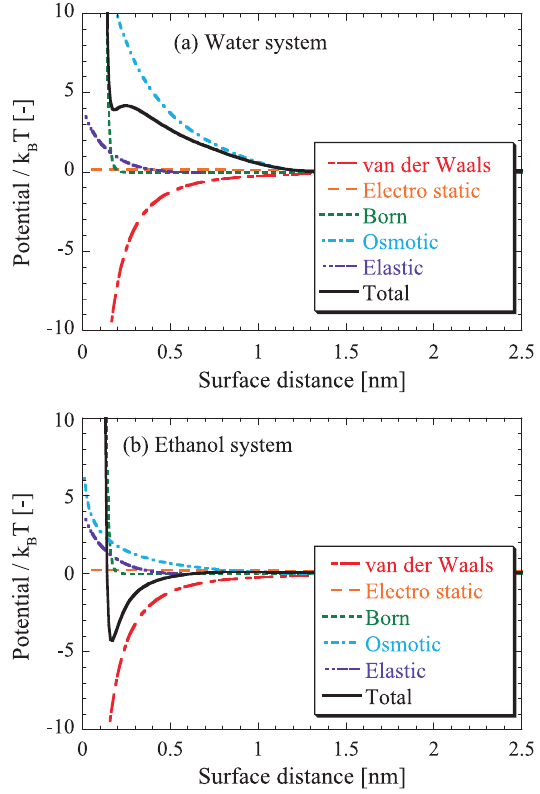
Fig. 5 Individual and total interaction potentials of 1-thioglycerol- capped ZnS nanoparticles calculated for pure (a) water and (b) ethanol systems. All the calculation parameters were as listed in Table 1, and the particle size was 2 nm.